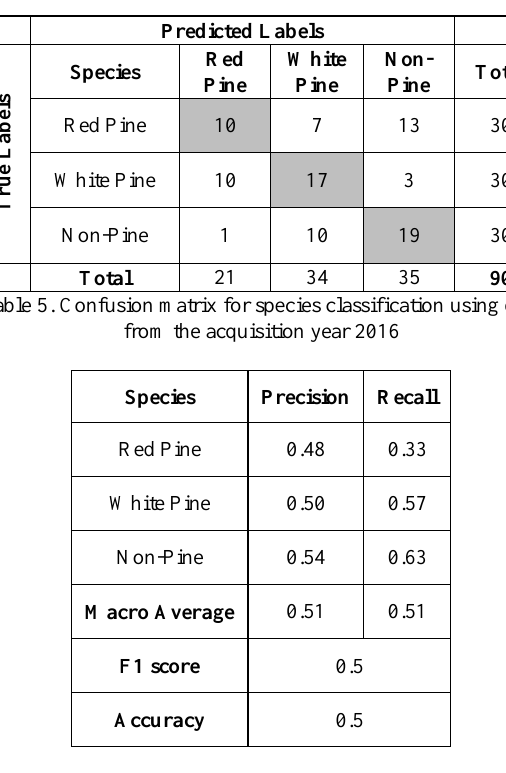
Table 6. Performance measures for Species Classification using data from the acquisition year